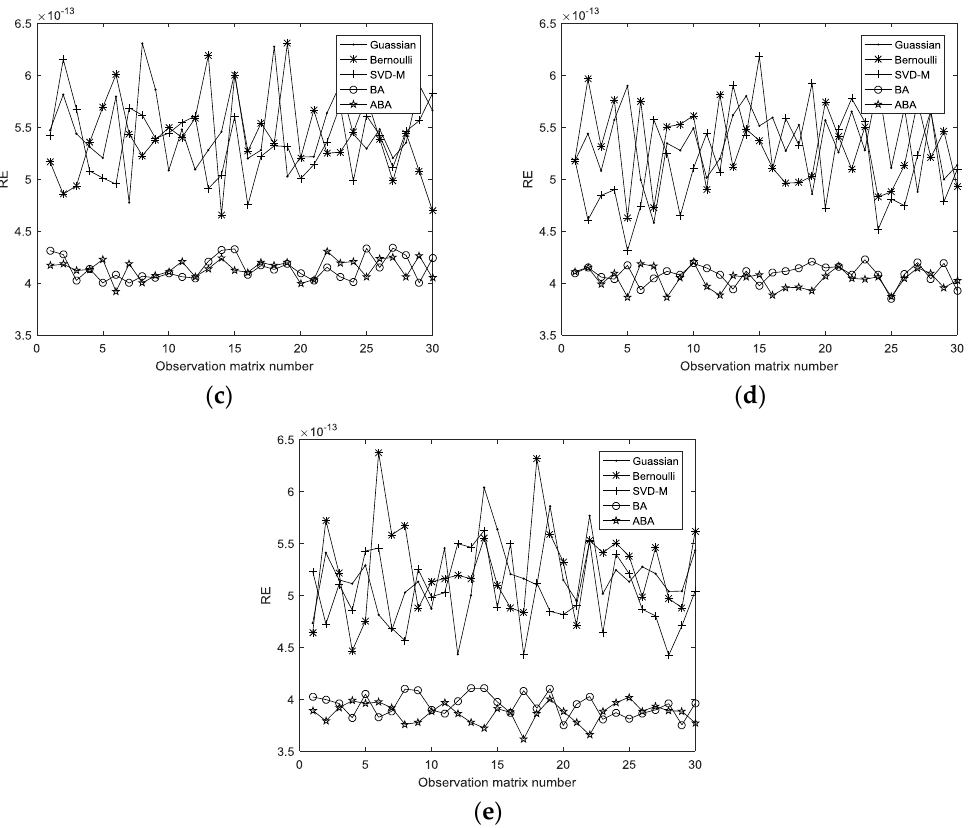
Figure 5. Reconstruction error of each algorithm to signal-2 with different compression ratio: ( a ) Rate = 0.3; ( b ) Rate = 0.35; ( c ) Rate = 0.4; ( d ) Rate = 0.45; ( e ) Rate = 0.5.